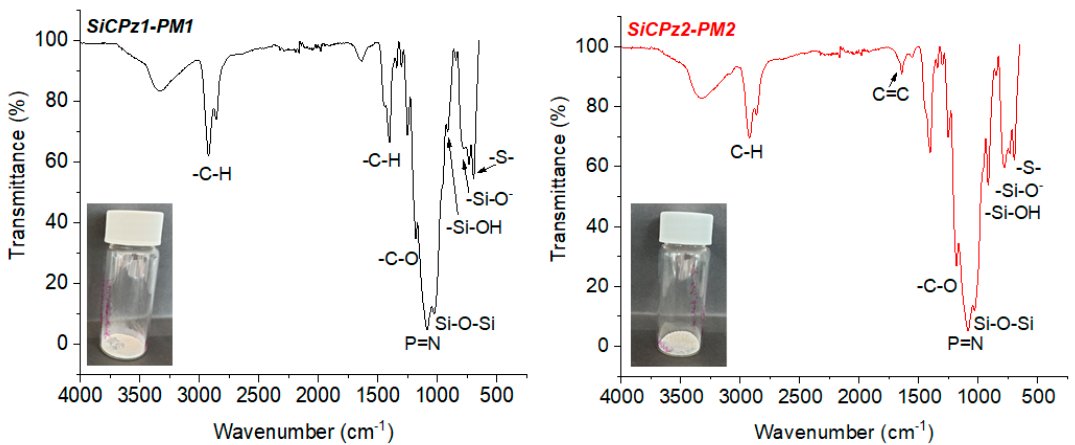
Figure 4. FT-IR spectra of porous microparticles SiCPz1-PM and SiCPz2-PM after surfactant removal, inset: powder-like microparticles image.